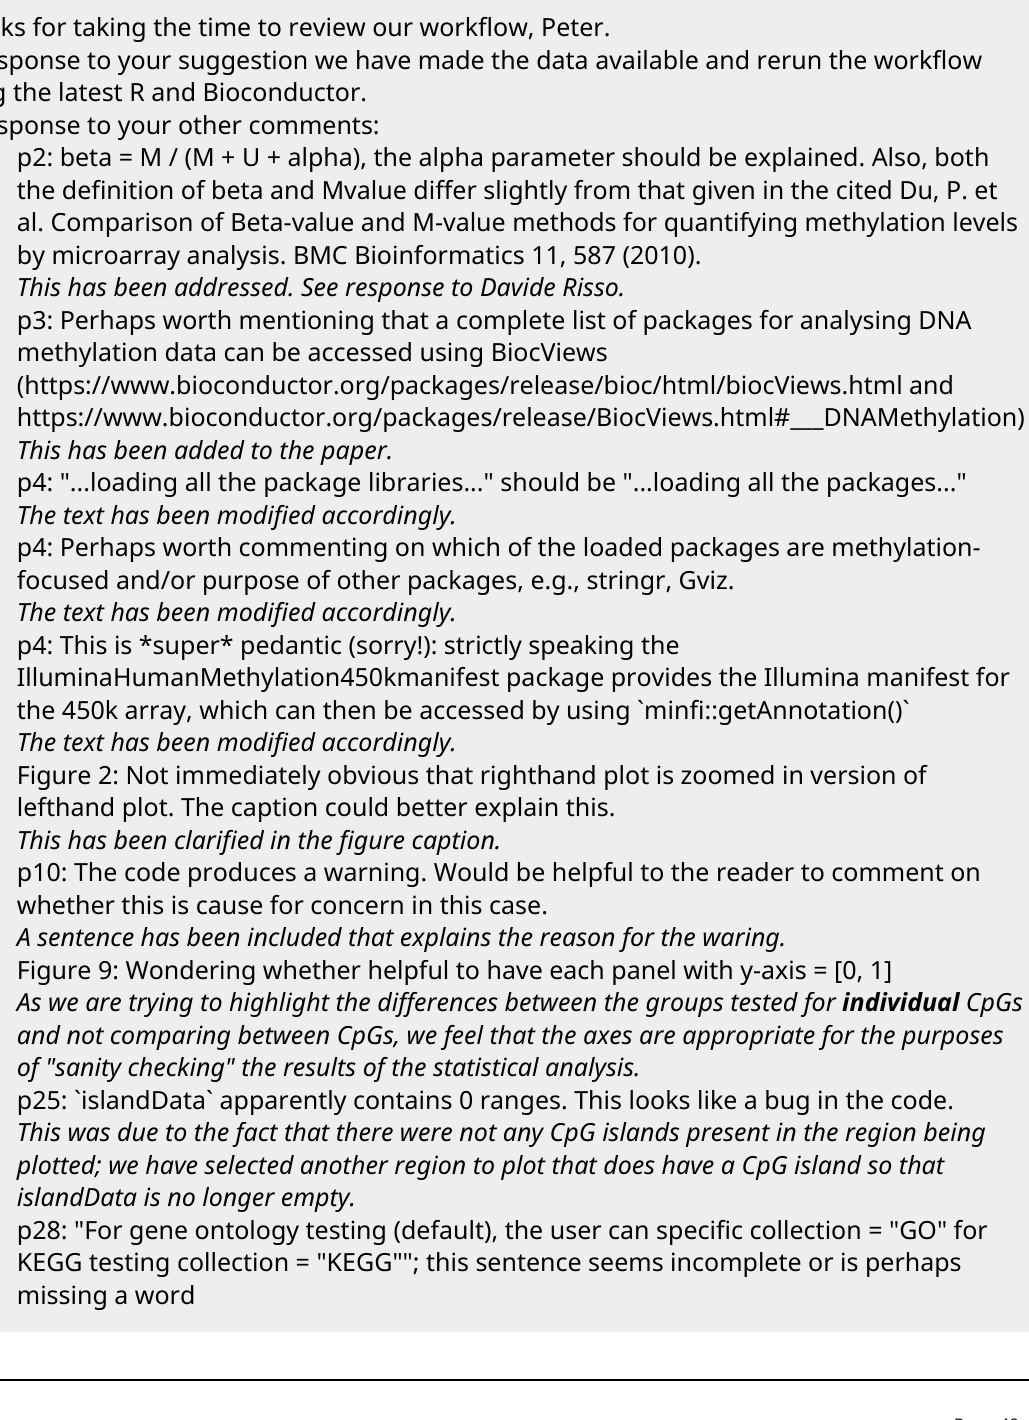
Figure 2: Not immediately obvious that righthand plot is zoomed in version of lefthand plot. The caption could better explain